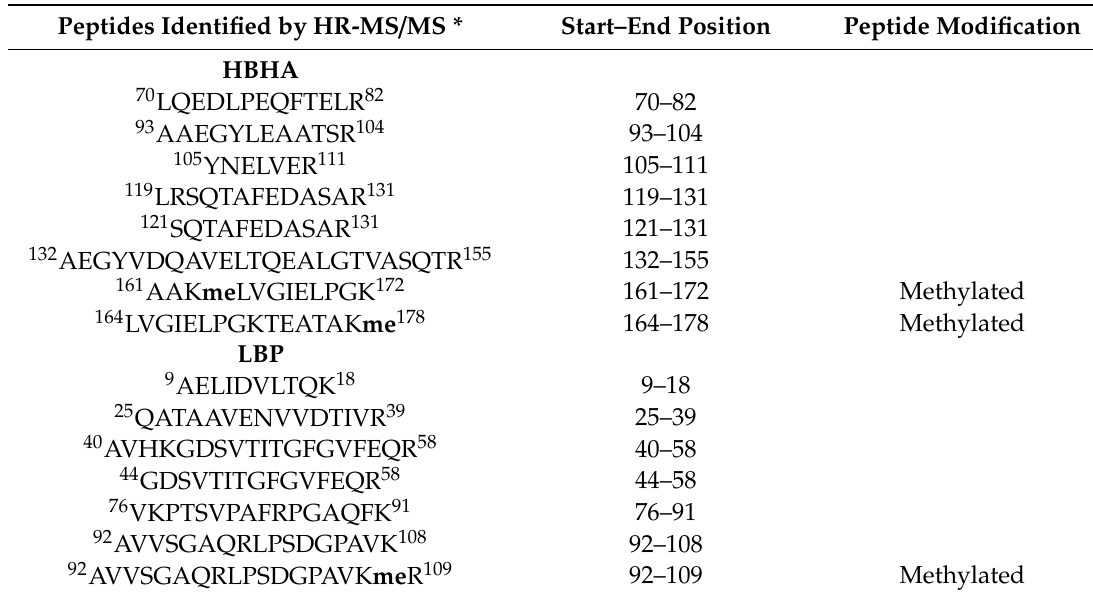
Table 3. Identification of HBHA and LBP by mass spectrometry